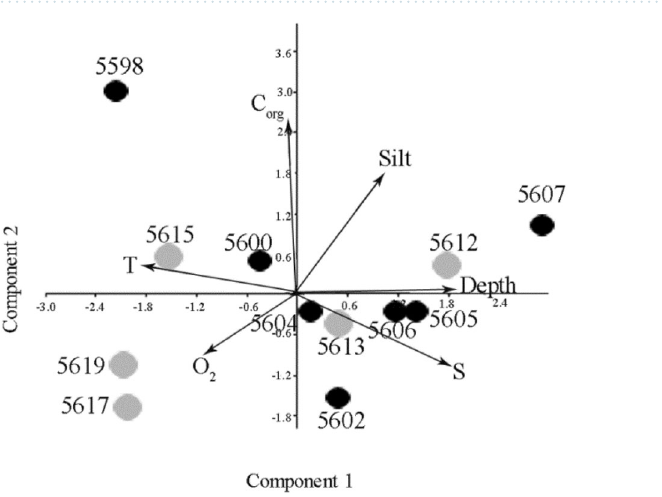
run-off was noted at the station 5620 closest to the mouth, where the At/S ratio is 0.089 (Fig. 1c). The influence of the river run-off can be traced up to 150 km away from the southern site, which is 12 nautical miles from the river mouth. With distance from the coast, the influence of the river run-off noticeably decreases, and the ratio does not exceed 0.071, but this clearly shows the presence of freshwater in the entire water column along the transect. In the southern part of the section, between stations 5617 and 5618, a vertical frontal zone is expressed, which is presented as a marginal filter, where the maximum sedimentation of suspended allochthonous mat- ter occurs 19 . The entire water column along the section is undersaturated with aragonite, and in the area of the maximum impact of the Kolyma run-off, Ω Ar is 0.4–0.6 (Fig. 1d). The vertical front is clearly pronounced, then it increases in the seaward part and reaches 0.95 at the northernmost station of the section 5612 in the 20 m layer. At stations 5612 and 5613, as in the case of the Indigirsky section, the upwelling of bottom waters with a lower Ω Ar is observed.